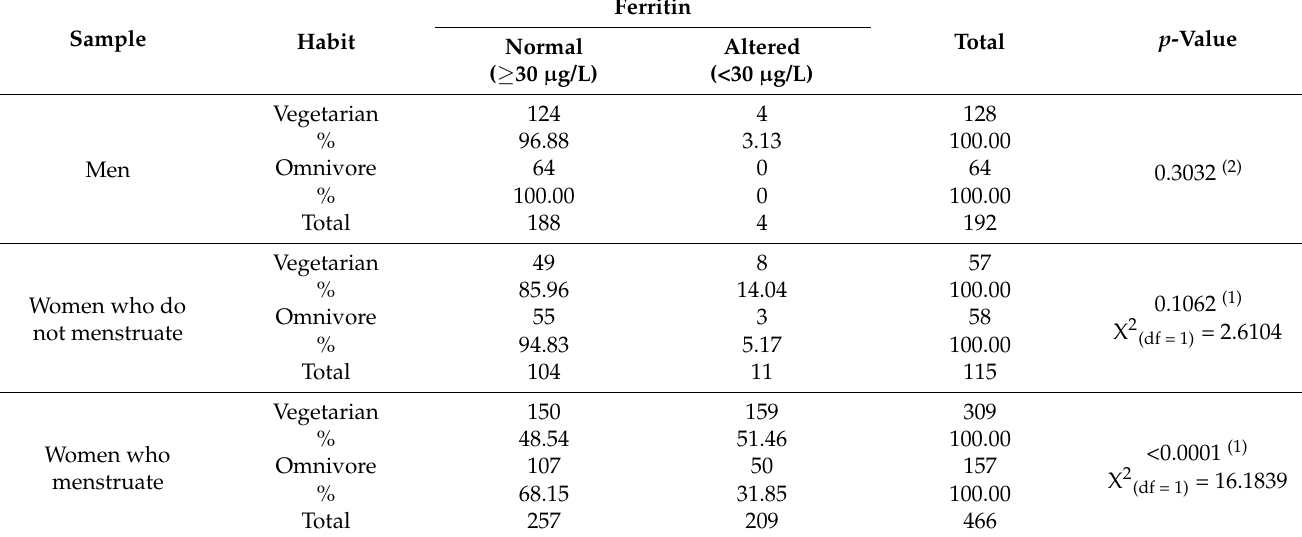
Table 4. Diagnosis of iron deficiency among men and women who do not menstruate and menstruate based on eating habits.